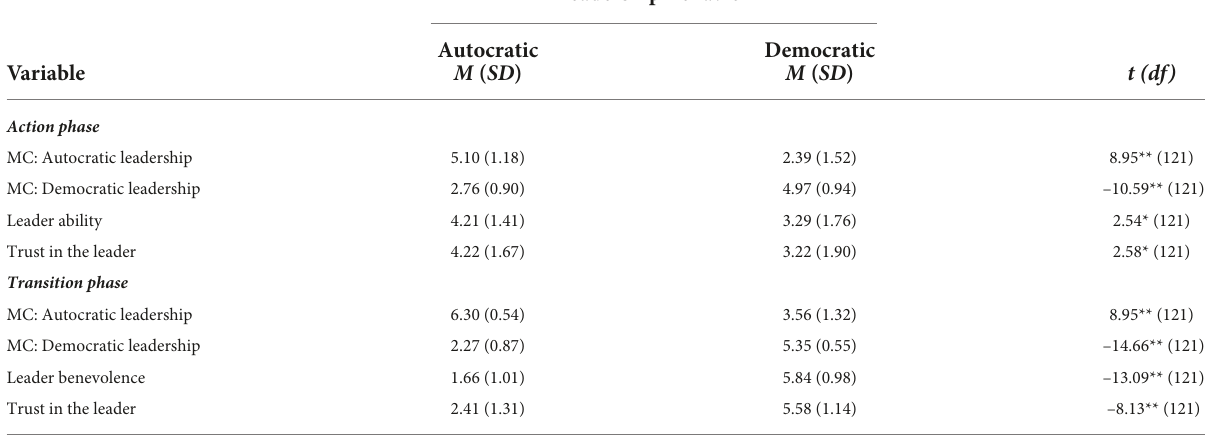
TABLE 3 Mean values, standard deviations, and significances of differences between experimental conditions (Study